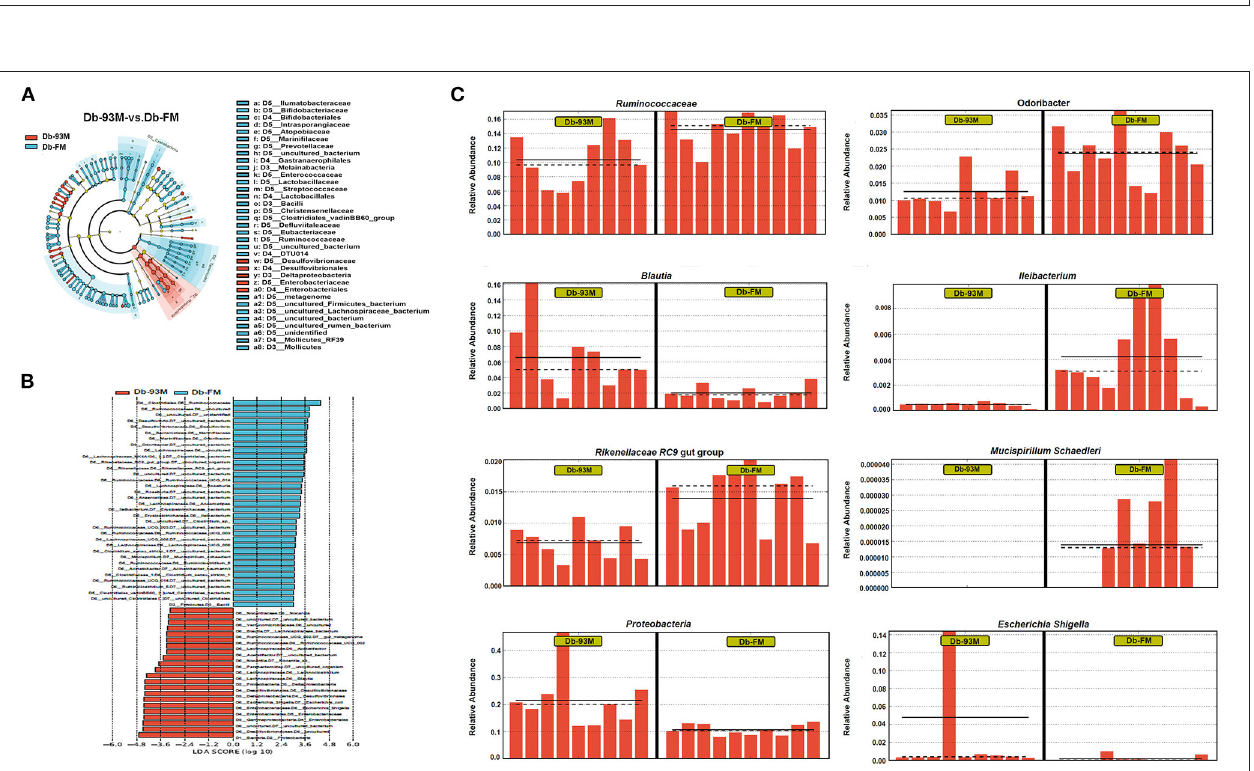
FIGURE 6 | LEfSe analysis of gut microbiota. (A) Effect size of significantly enriched taxa in each group when performing a comparison between Db-93M group and Db-FM group. (B) Taxonomic cladogram obtained using LEfSe analysis result from the comparison between Db-93Mgroup and Db-FM group. (C) Relative abundance of representative bacterial taxa in the gut microbiota of Db-93M group and Db-FM group identified by LEfSe analysis.